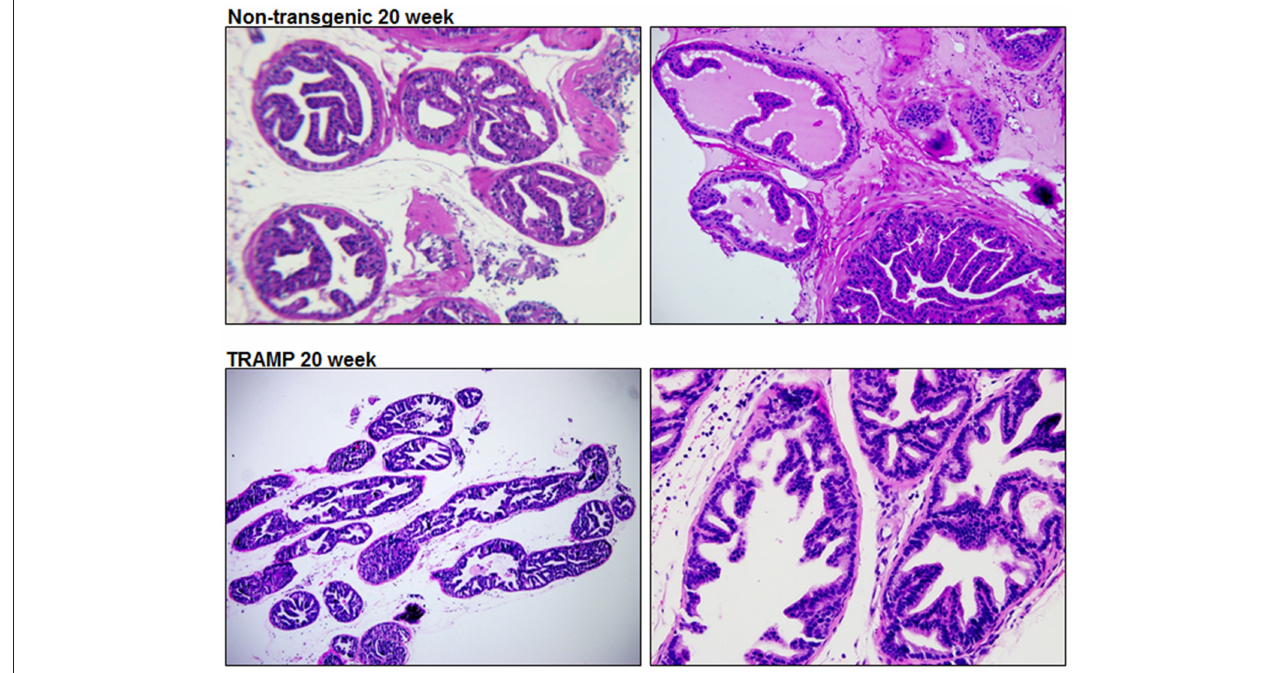
FIGURE 1 | Histology of dorsolateral prostate of TRAMP mice and non-transgenic littermates. Representative staining image of histopathology of 20 week old TRAMP mice and non-transgenic littermate. A typical dorsolateral prostate from a non-transgenic mouse exhibited acini with abundant eosinophilic intraluminal secretions. TRAMP mouse exhibited adenocarcinoma with extensive epithelial stratification, crowded cribriform structures accompanied with marked thickening, remodeling and hypercellularity of the fibromuscular stroma. (Magnification x20 and x40).